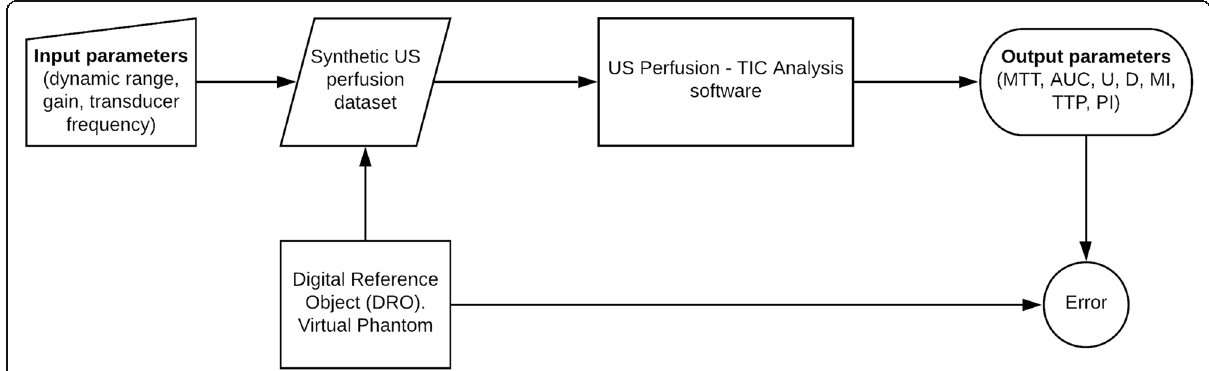
Fig. 1 Schematic diagram of the process for theoretically obtaining the optimum input parameters minimising output variability. AUC area under